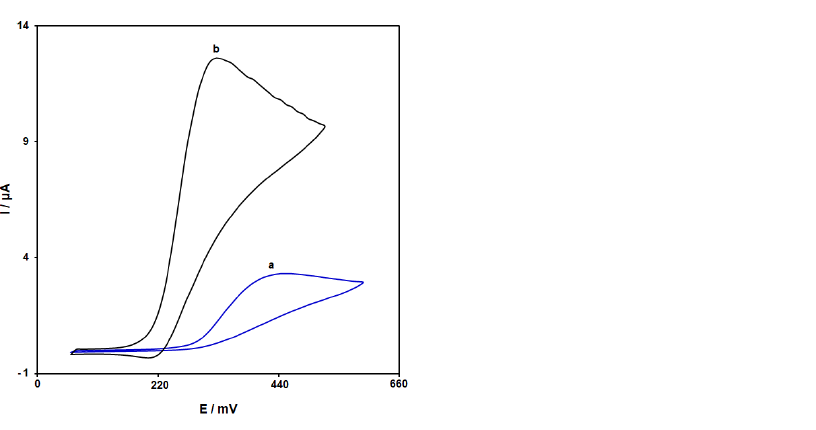
Figure 6. Cyclic voltammograms captured of (a) bare SPGE and (b) NiCo-MOF/SPGE for epinine (100.0 µM) in PBS (pH 7.0; 0.1 M) at scan rate of 50 mV/s.